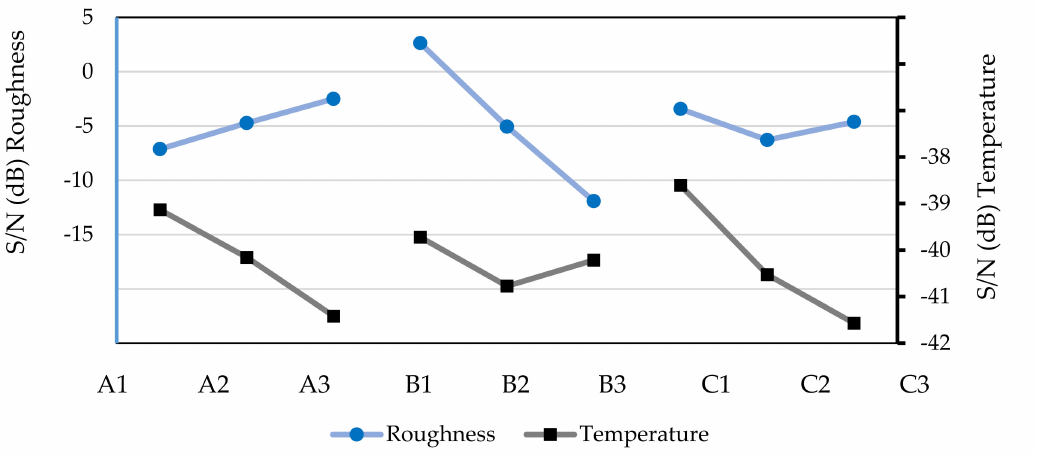
Figure 5. S/Ns to surface roughness of the workpiece and chip temperatures based on the machining tests without lubrication